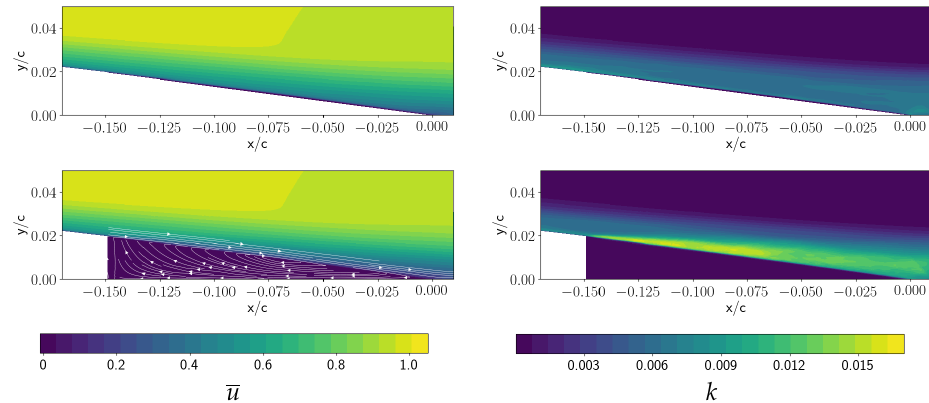
Figure 7. Mean streamwise velocity ( left ) and turbulent kinetic energy ( right ) contours in tip ( top ) and root ( bottom )